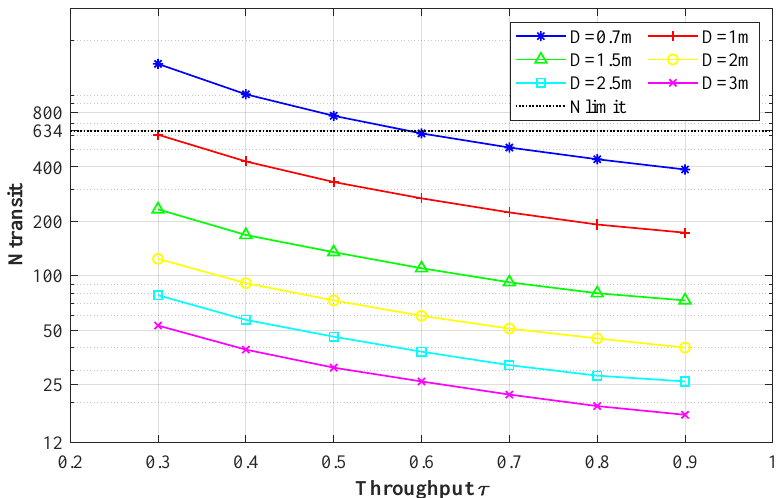
Figure 3. Number of transits to achieve SNR goal under different apertures and throughput for GJ 1214 b.